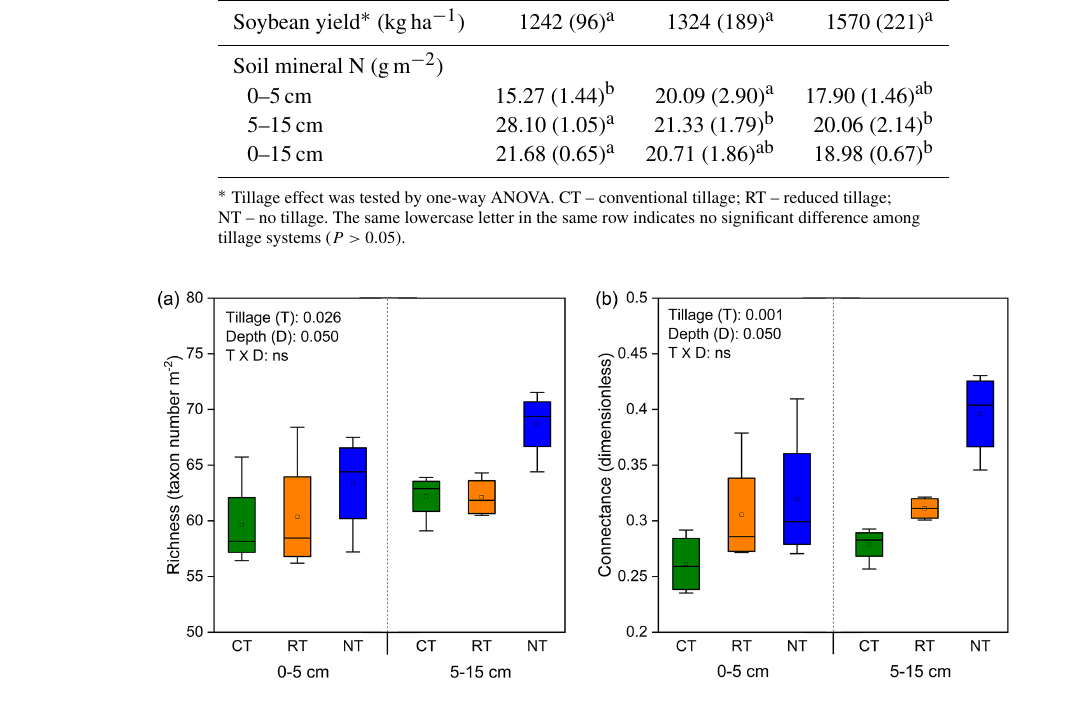
Figure 1. Changes in soil food web complexity (indicated by richness, a , and connectance, b ) under different tillage systems. CT – conven- tional tillage; RT – reduced tillage; NT – no